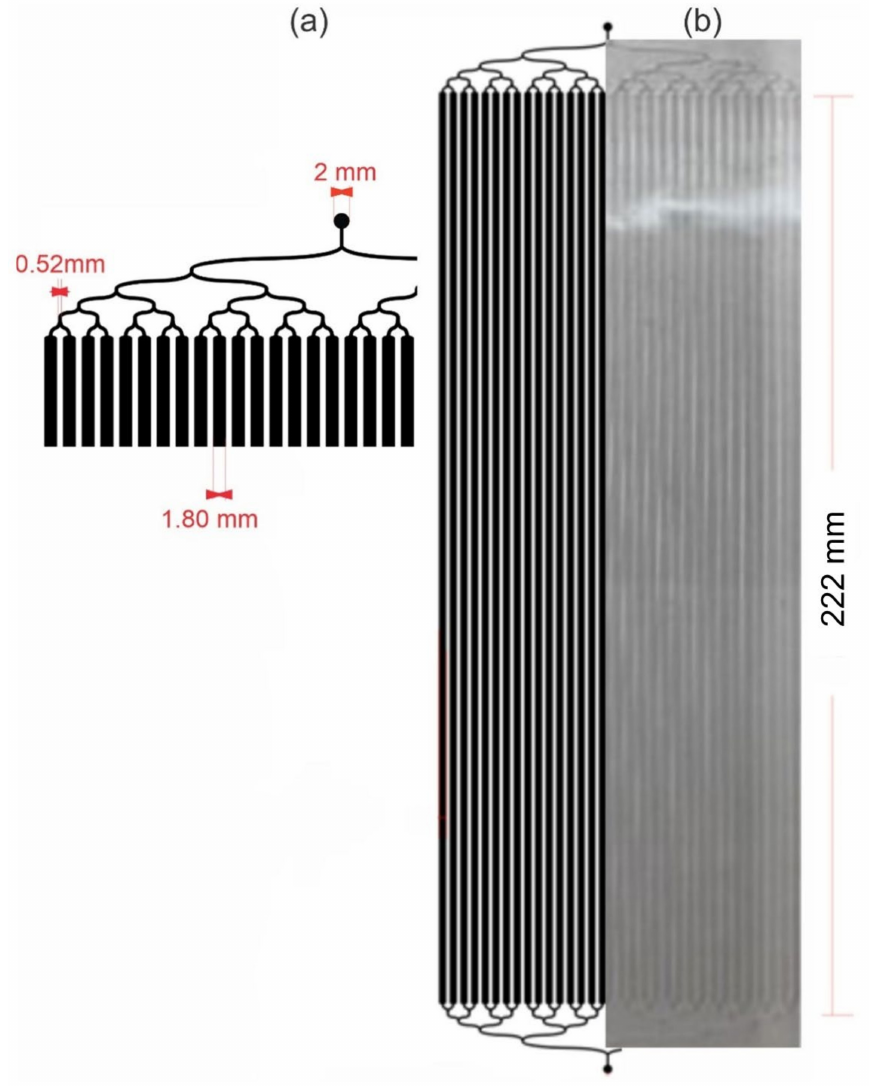
Figure 2. LM bioreactor used in this study. ( a ) Design of microchannels with one inlet, one outlet, and 32 cell culture cisterns. ( b ) Polydimethylsiloxane/glass LM bioreactor with a 182 cm 2 surface area, height of 200 µ m, and a total internal volume of 2.8